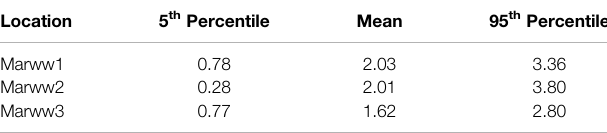
TABLE 1 | Average head differences (m) at MAR locations during 20 years simulation period (MAR scenario minus no-MAR